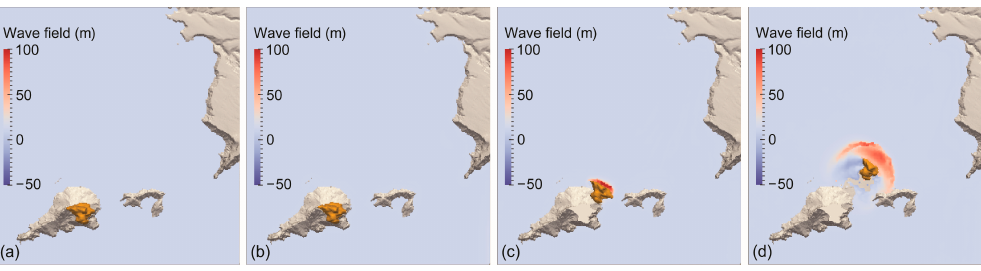
Figure 5. Time history of wave generation in scenario 1 at ( a ) t = − 23.3 s, ( b ) − 9.9 s, ( c ) 3.5 s, and ( d ) 16.9 s.